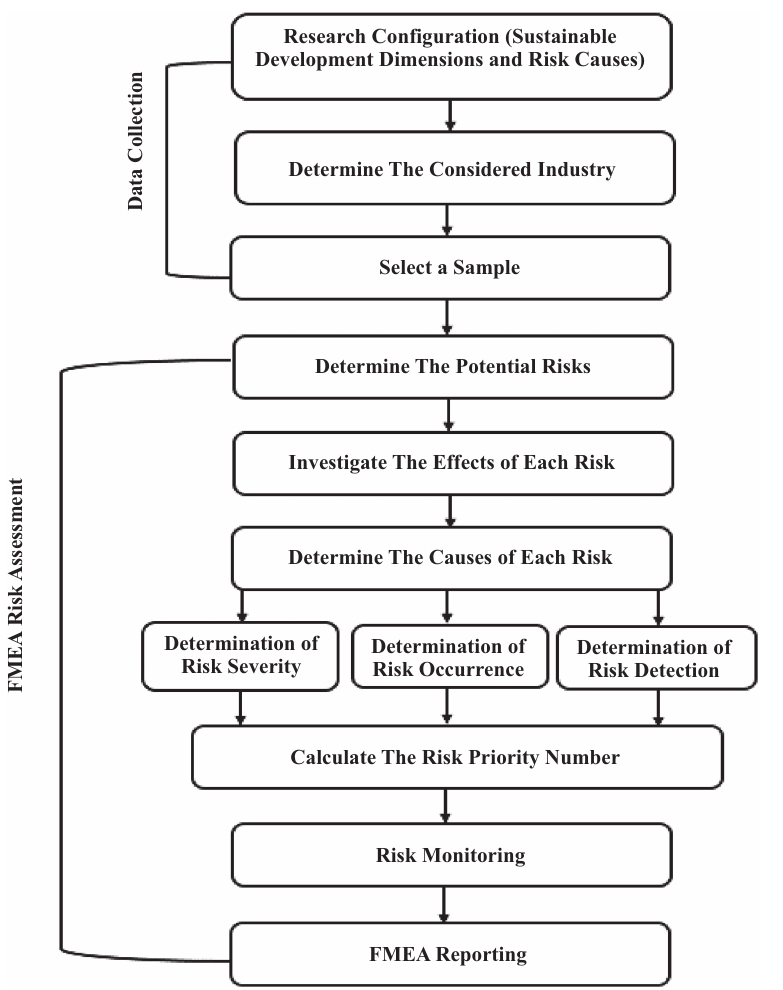
Figure 2. The flowchart of research